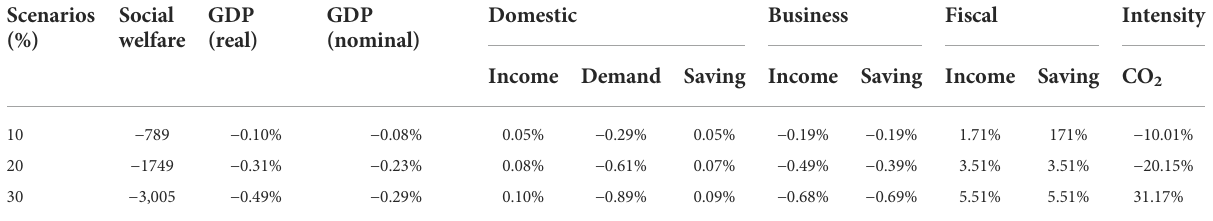
TABLE 5 Macroeconomic variables statistics.